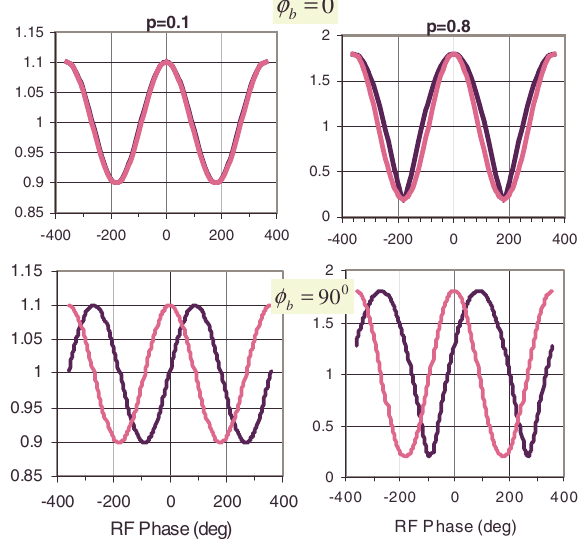
FIG. 2. (Color) Envelope of resonator resultant field for differ- ent beam amplitude and phase, relative units. F curve: reference